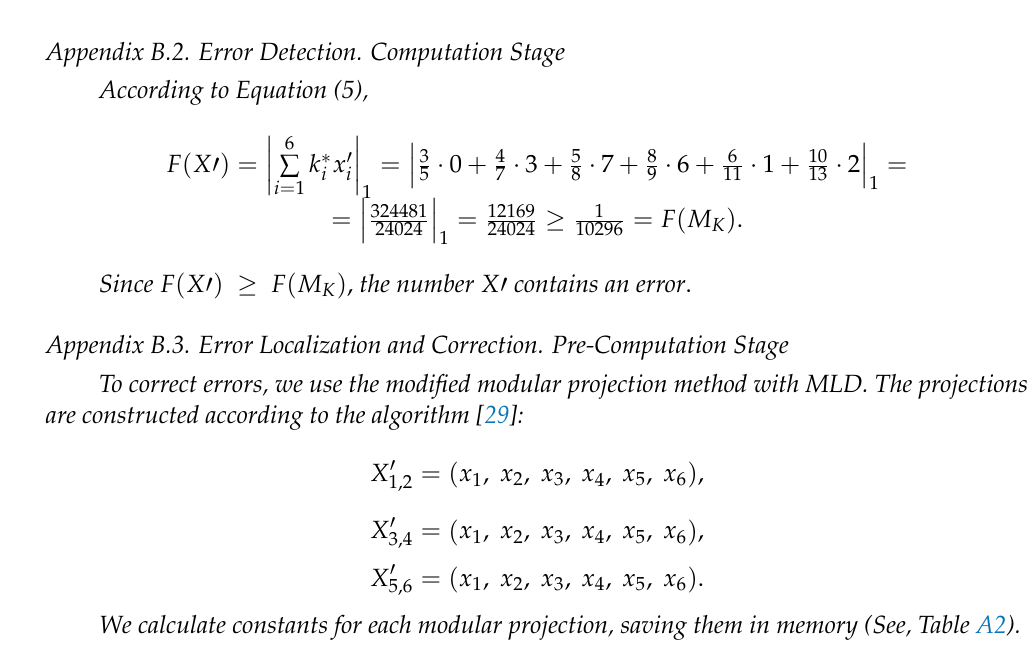
Table A2. Pre-computed constants for each modular